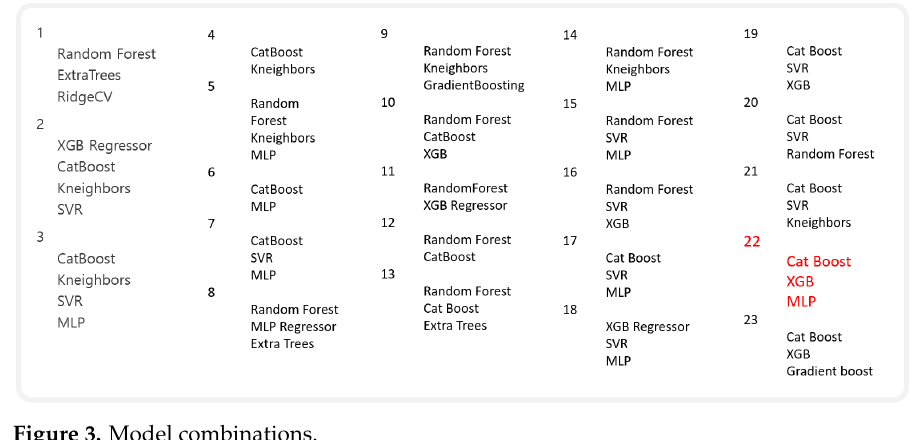
Figure 3. Model combinations.